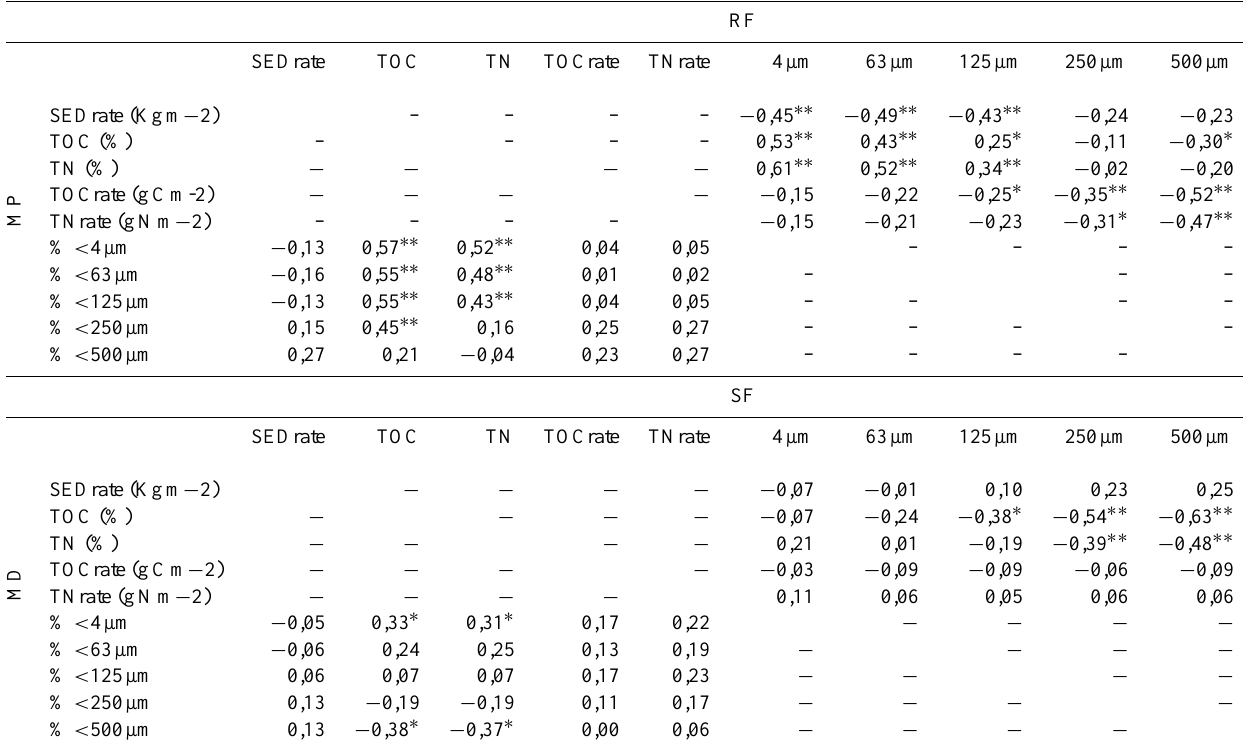
Table 3. Bivariate correlation between sediment particle-size, carbon and nitrogen concentration and deposition rates (sediment, TOC and TN). Data has been separated by study site: (a) RF, MP; (b) SF, MD. For an easier interpretation, correlations not related to the investigated aspects (see methods) are not